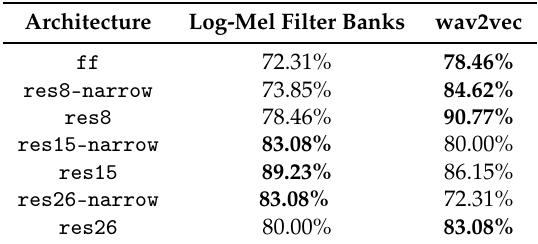
Table 5. Test accuracy on the Lithuanian